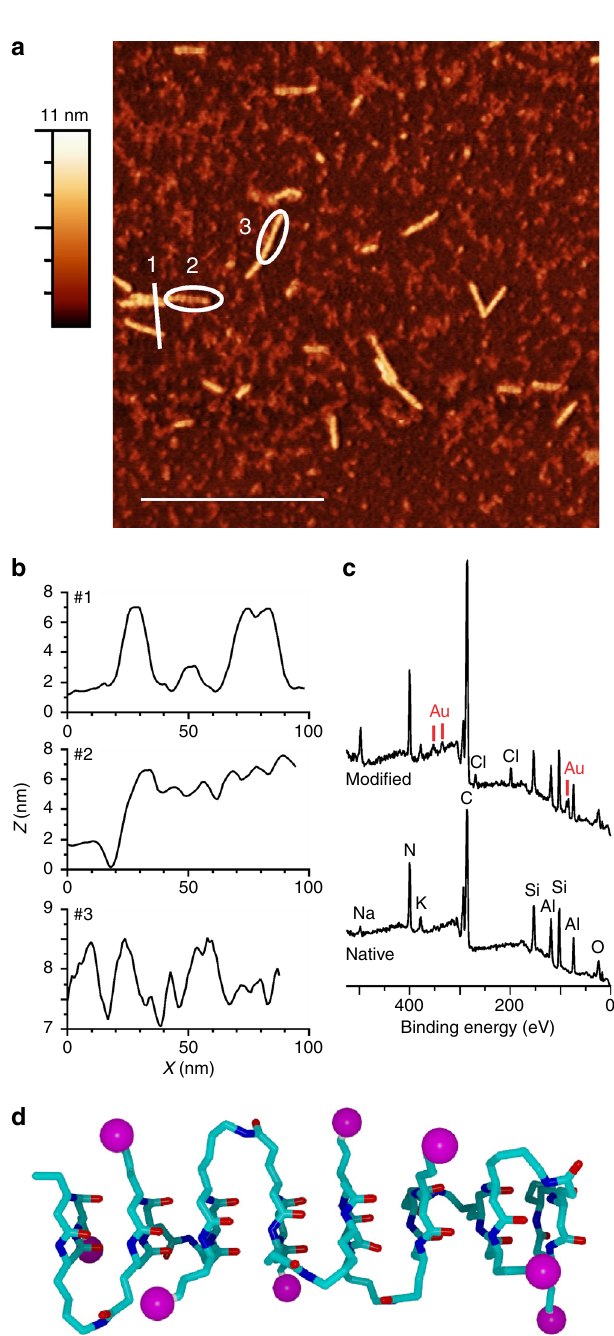
Fig. 5 Nanorod functionalization. a AFM image (300 nm scale bar) of nanorods functionalized with 1.4 nm Au nanoparticles deposited on mica from a basic solution (0.1 mg mL − 1 ; pH ≈ 11). Color bar indicates the Z heights in the images, with the baseline (black) set to 0 nm. b Height pro fi les are shown across (1) and along the long axis (2 and 3) of decorated nanorods. c XPS survey scan con fi rming the presence of Au after functionalization. d Molecular model of the cyclic β -tripeptide